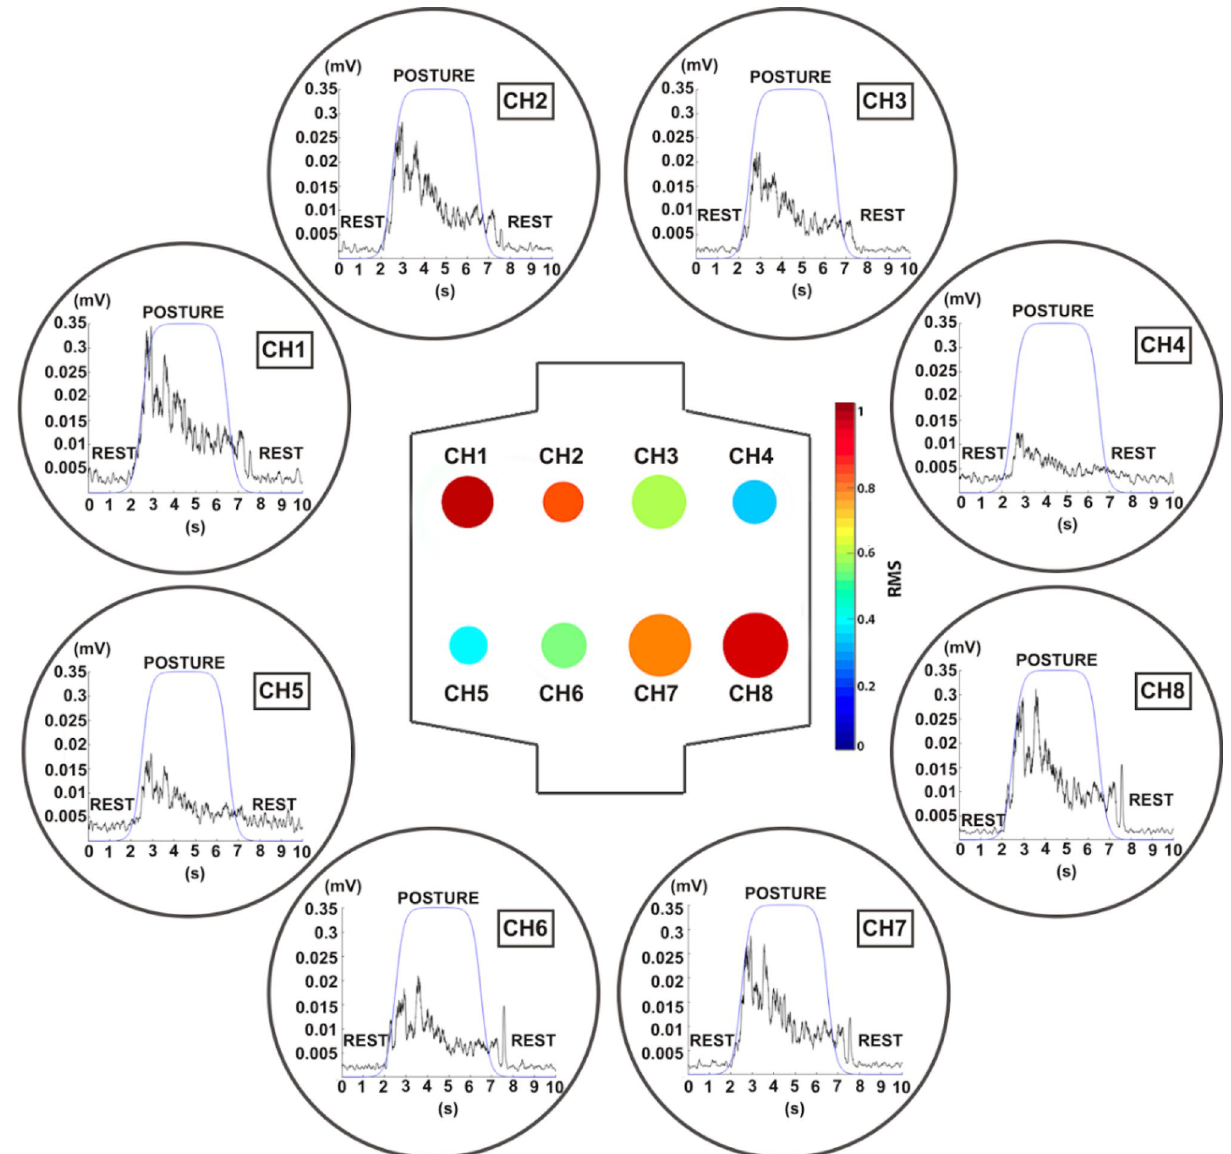
Figure 1. Representative bubble plot showing the signal quality during the flexion movement of the middle finger in a single participant. Each bubble shows the average normalized RMS value across repetitions of the same movement (color code) and its standard deviation (diameter). The corresponding average sEMG signal across trials is shown for each unipolar channel. Figure created with MatLab 2020a and Microsoft PowerPoint